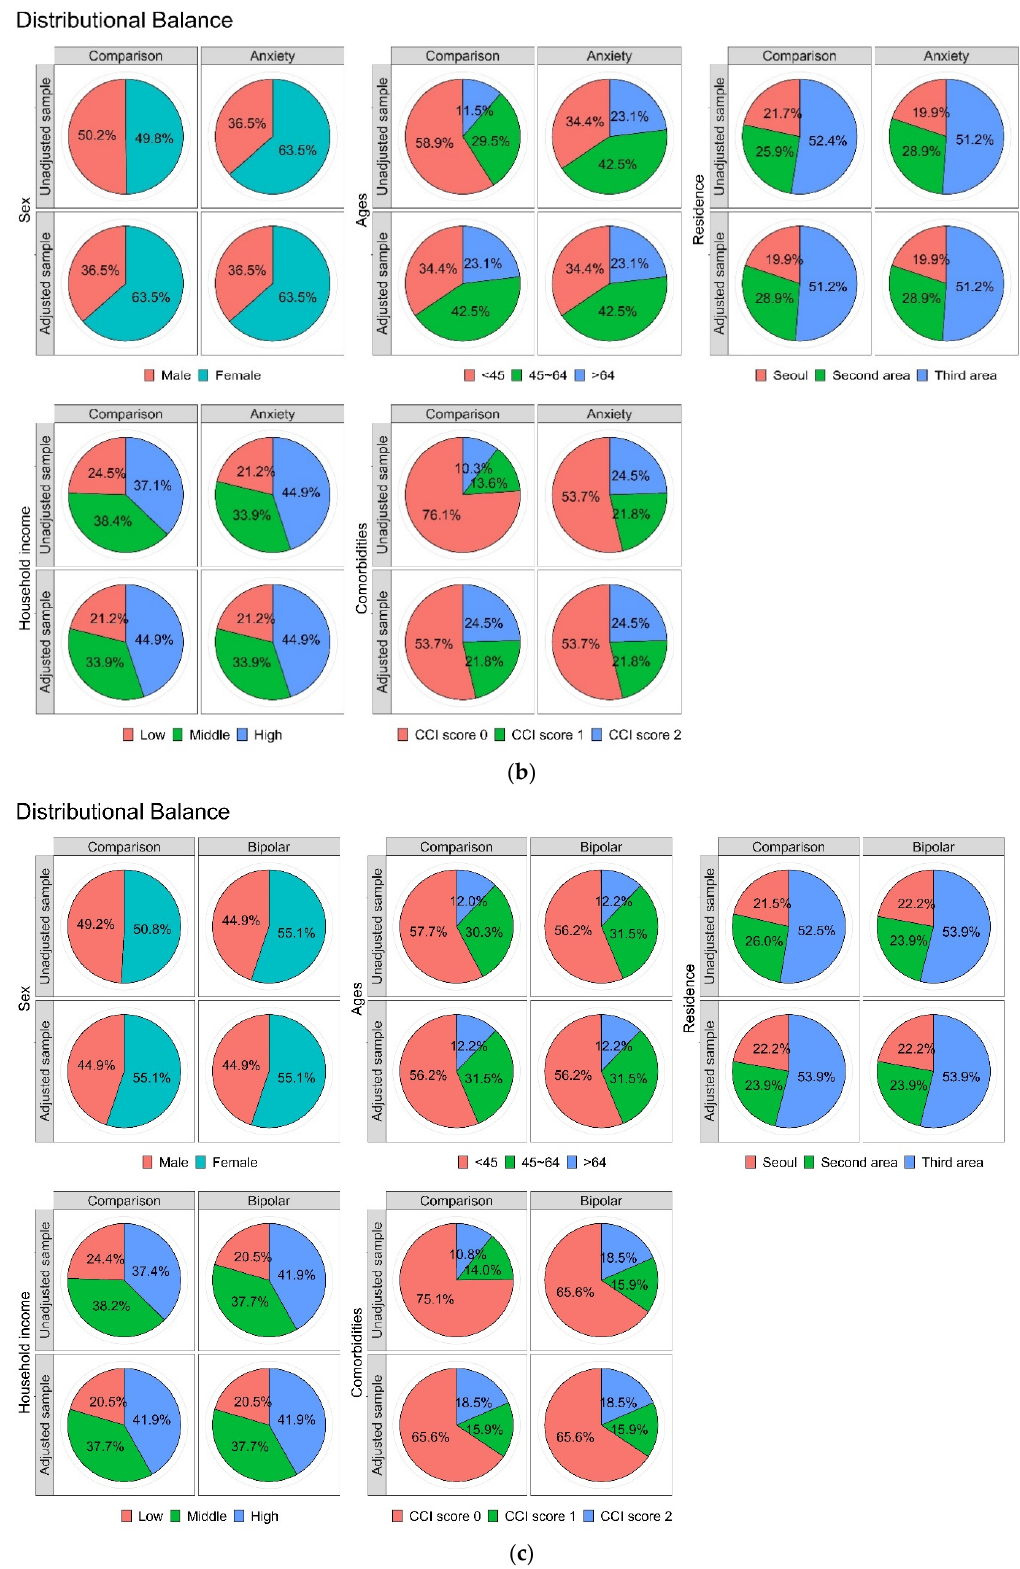
Figure 2. ( a ) Matching of the five main independent variables illustrated by balanced plots between comparison and depression groups. ( b ) Matching of the five main independent variables illustrated by balanced plots between comparison and anxiety groups. ( c ) Matching of the five main independent variables illustrated by balanced plots between comparison and bipolar